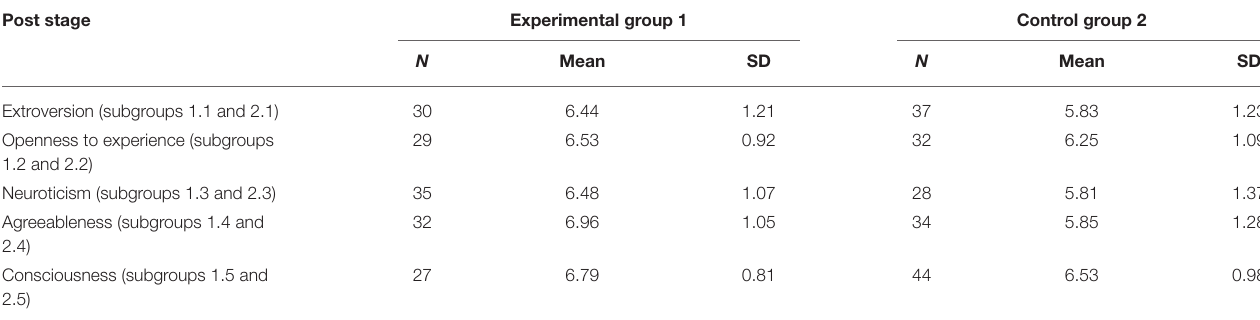
TABLE 1 | Emotional competences development (ECD) posttest in experimental and control